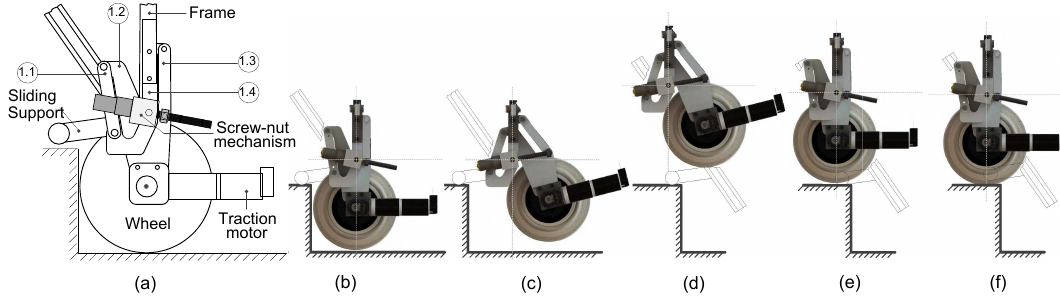
Figure 3. Actuating sequence of the rear climbing mechanism. . In ( a ) the wheel makes contact with the ground. In ( b ) the sliding support slides and makes contact with the step tread and the wheel is off the ground. In ( c ) the screw-nut mechanism is again actuated and the sliding support continues to slide. In ( d ) the sliding support is completely deployed. In ( e ) the screw-nut mechanism is actuated and the wheel moves backwards to its initial point. In ( f ) the wheel again makes contact with the ground and the sliding support is retracted.